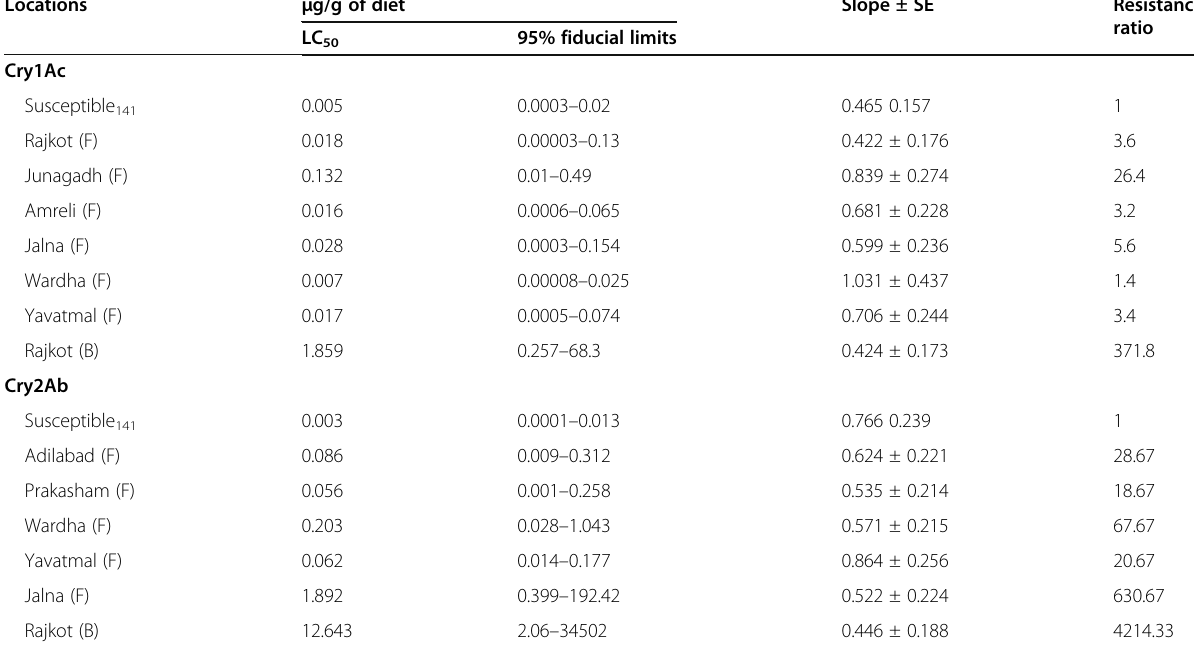
Table 2 Susceptibility of Pectinophora gossypiella to Cry1Ac and Cry2Ab Locations